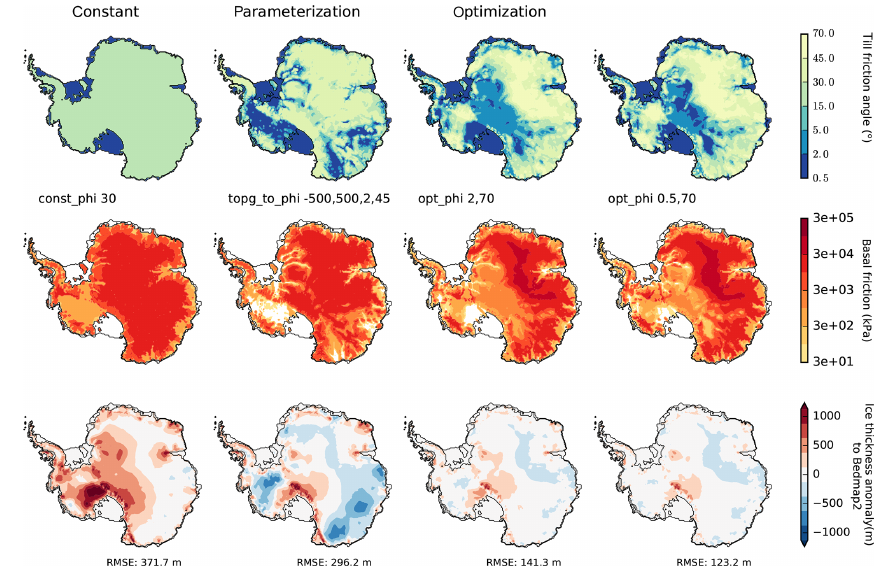
Figure 14. PISM equilibrium simulations for different basal friction fields ( τ c in middle row) based on different till friction angle distributions ( φ in first row). First column is with spatially uniform till friction angle of 30 ◦ , second column shows till friction angle according to PISM parameterization as function of bed topography and last columns use a simple inversion technique with different minimal φ i shows the resulting ice thickness anomaly to Bedmap2 observations (Fretwell et al., 2013), with improvements particularly in East Antarctica and Siple Coast region and overall RMSE reduced to 123m (with parameters ESIA=1 and C d = 5mmyr − 1 ).